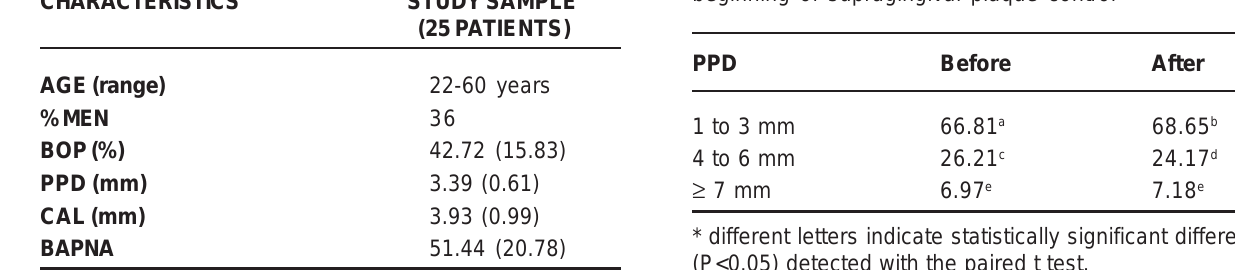
TABLE 3- Percentage of sites in the three categories of probing pocket depth (PPD) before and 21 days after the beginning of supragingival plaque control